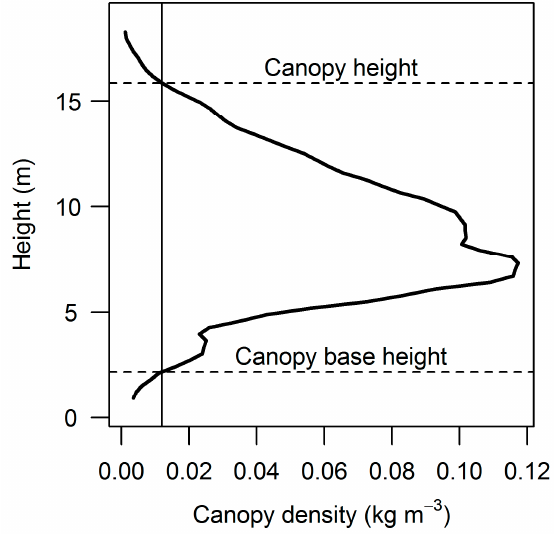
Figure 3. Canopy density profile of a typical plot and a depiction of canopy fuel parameters commonly used to predict fire behavior. Canopy bulk density (CBD), the maximum of the canopy density profile, is 0.117 kg m − 3 for this plot. Canopy base height (CBH) and canopy height (CH) are represented by horizontal dashed lines, where the canopy density profile intersects 0.012 kg m − 3 , shown as a vertical line.